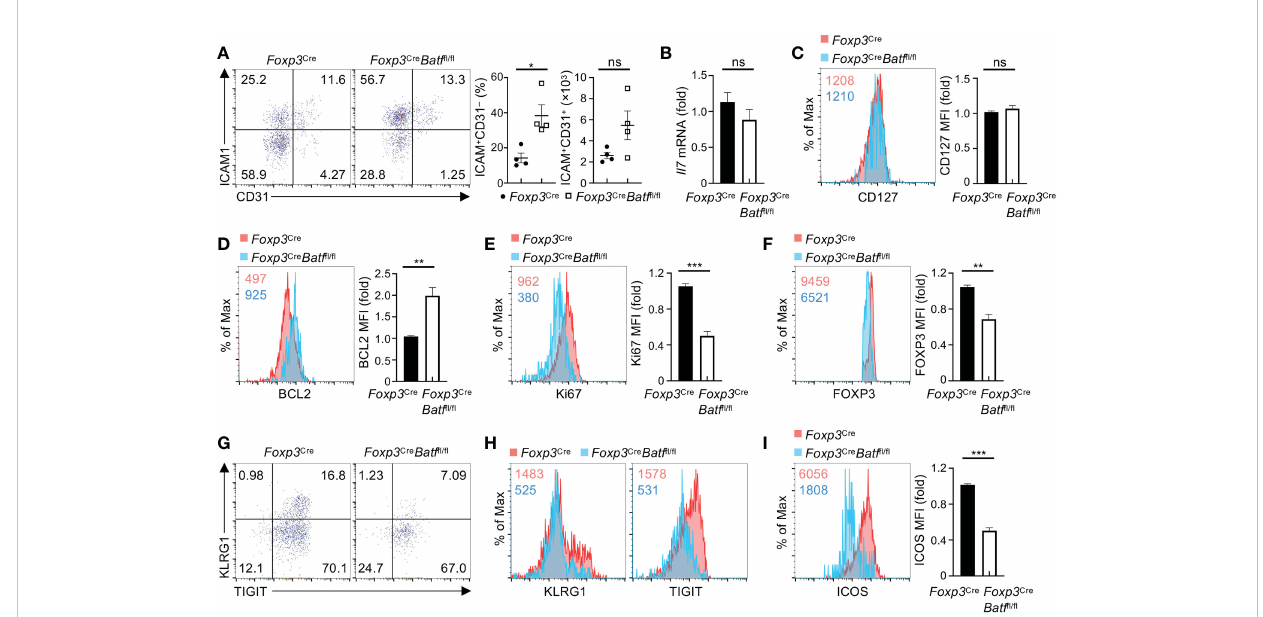
FIGURE 7 BATF promotes BM Treg homeostasis and expression of eTreg-associated markers in response to IL-7. (A) Flow cytometry analysis of CD31 and ICAM1 expression on BM stromal cells from Foxp3 Cre and Foxp3 Cre Batf fl / fl mice. Frequencies (middle) and numbers (right) of ICAM1 + CD31 – stromal cells ( n = 4 per group). (B) Relative expression of Il7 mRNA in lineage-negative BM cells enriched from Foxp3 Cre and Foxp3 Cre Batf fl / fl mice. (C) Flow cytometry analysis of CD127 expression on Foxp3 Cre and BATF-de fi cient BM Tregs. Right, fold changes of CD127 MFI on BM Tregs. (D, E) Flow cytometry analysis of BCL2 (D) and Ki67 (E) expression in Foxp3 Cre and BATF-de fi cient BM Tregs stimulated with IL-7 for 48 h. Right, fold changes of BCL2 (D) and Ki67 (E) MFI in BM Tregs. (F) Flow cytometry analysis of FOXP3 expression of Foxp3 Cre and BATF-de fi cient BM Tregs upon IL-7 stimulation. Right, fold changes of FOXP3 MFI on BM Tregs. (G) Flow cytometry analysis of KLRG1 and TIGIT expression on Foxp3 Cre and BATF- de fi cient BM Tregs stimulated with IL-7. (H) Expression of KLRG1 and TIGIT MFI on IL-7-stimulated Foxp3 Cre and BATF-de fi cient BM Tregs in (G, I) Flow cytometry analysis of ICOS expression on Foxp3 Cre and BATF-de fi cient BM Tregs upon IL-7 stimulation. Right, fold changes of ICOS MFI on BM Tregs. Data are representative of at least three independent experiments (A-I) . Data are the mean ± s.e.m. P values are determined by two-tailed Student ’ s t -test (A-F, I) . * P < 0.05, ** P < 0.01, and *** P < 0.001. ns, not signi fi